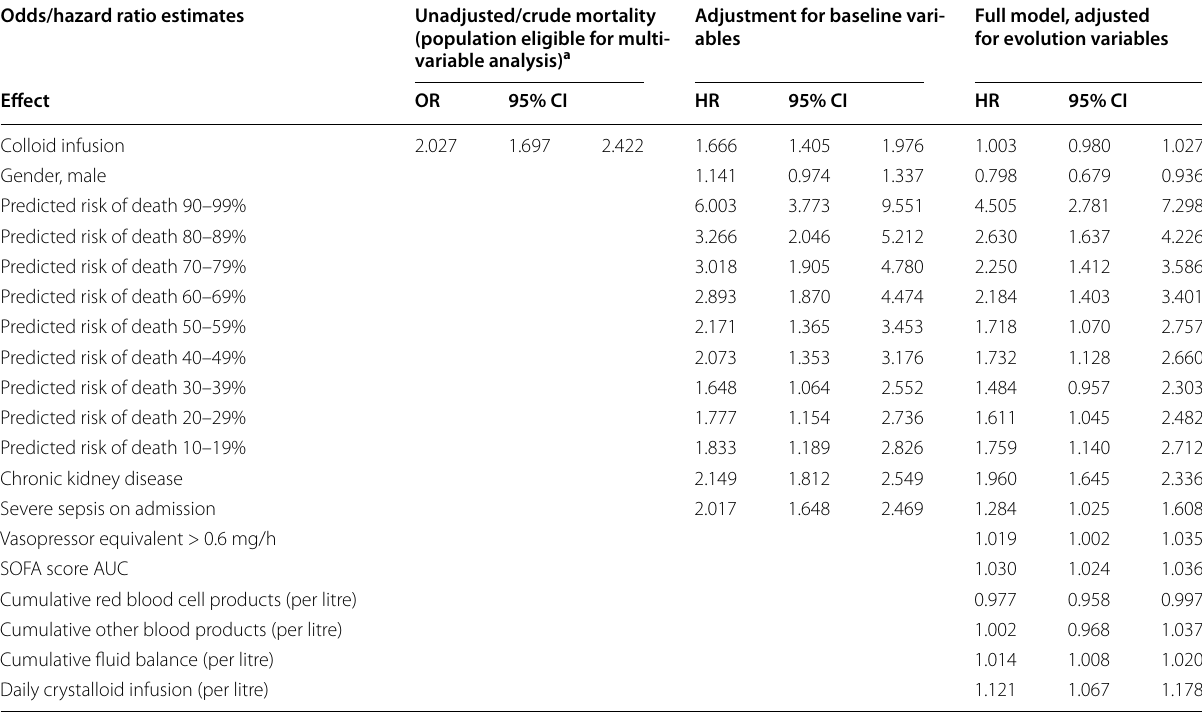
Table 2 Effects of colloid infusion on 90-day mortality in Cox regression